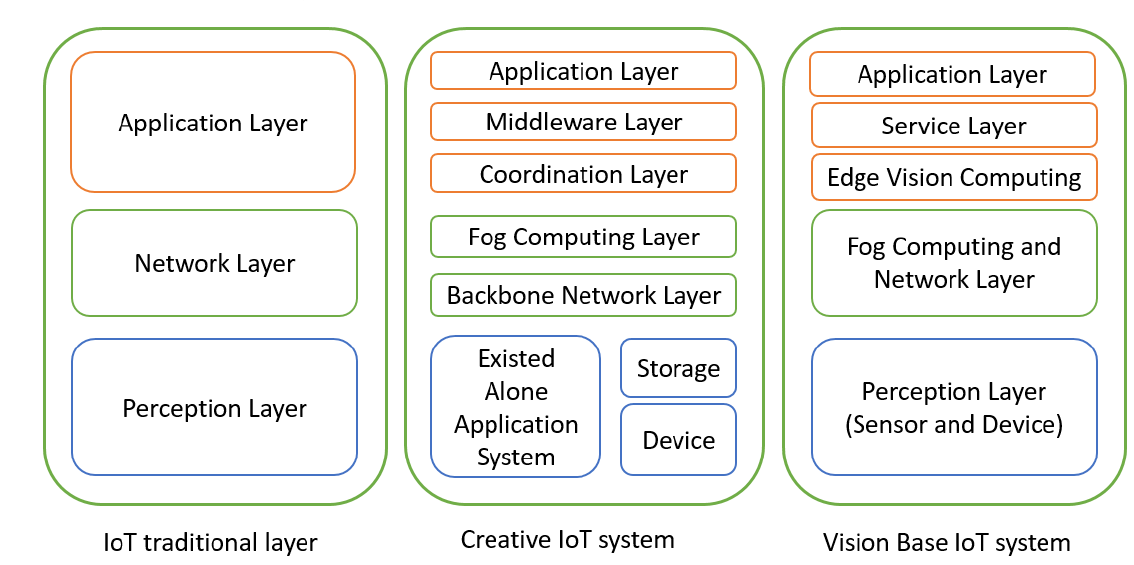
Figure 4. The proposed vision bases IoT architecture.